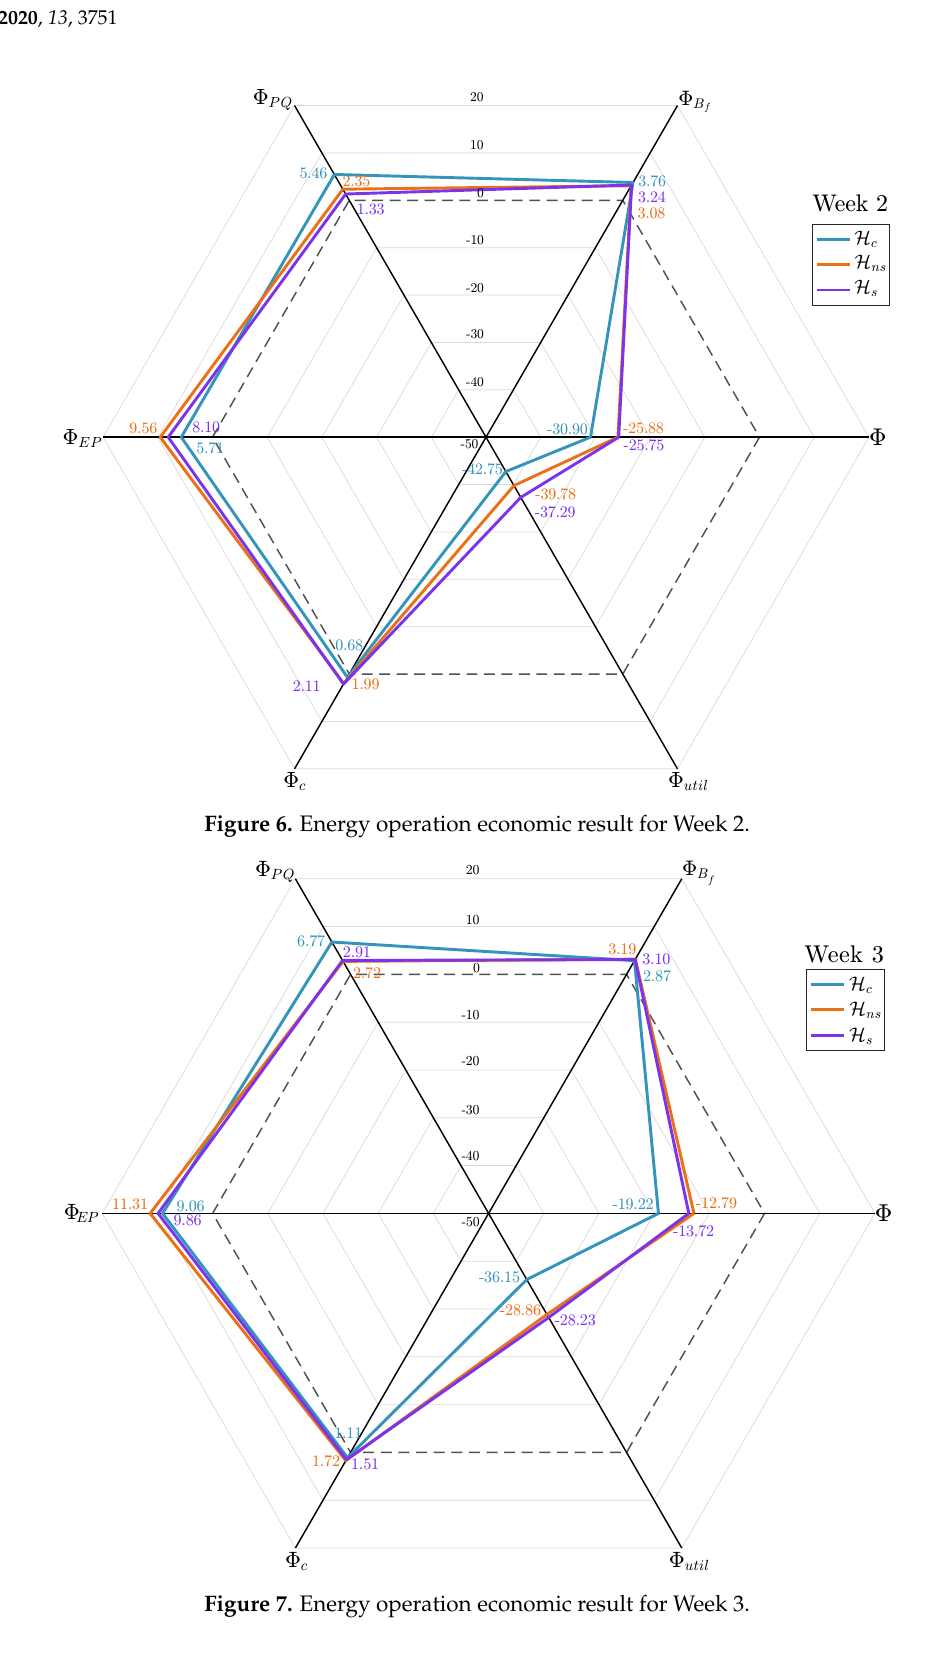
Figure 7. Energy operation economic result for Week